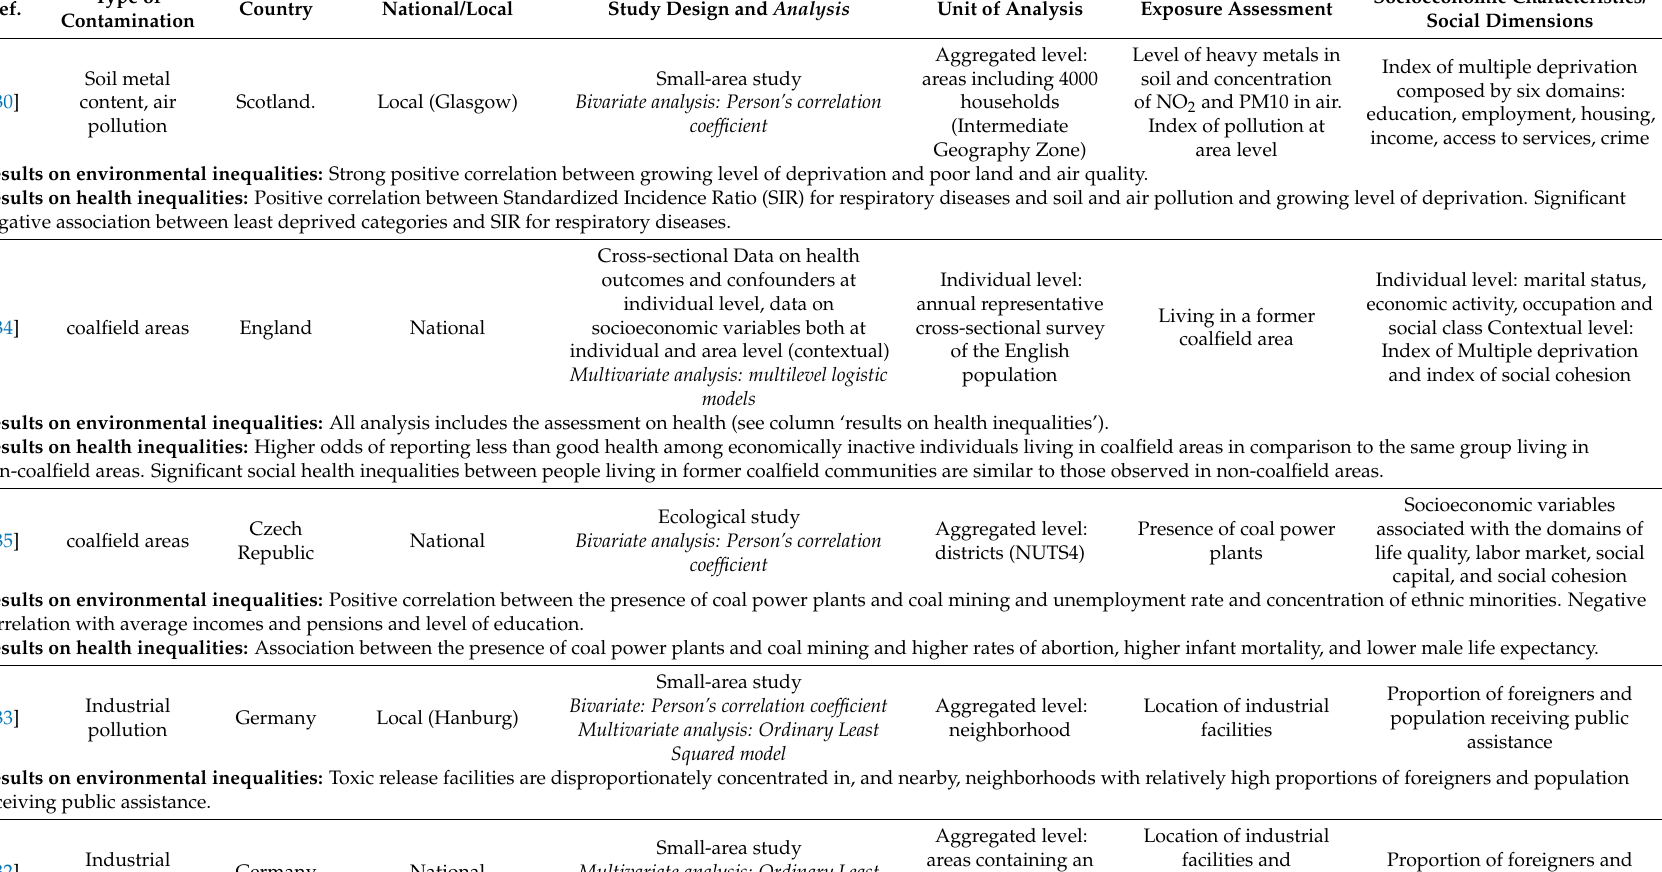
Table 2. Main characteristics and results of identified studies on distributive justice in industrially contaminated sites, 2010–2017.